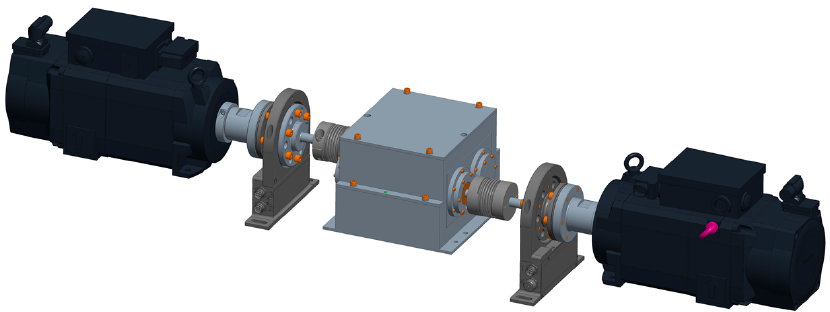
Figure 10. Physical validation environment.